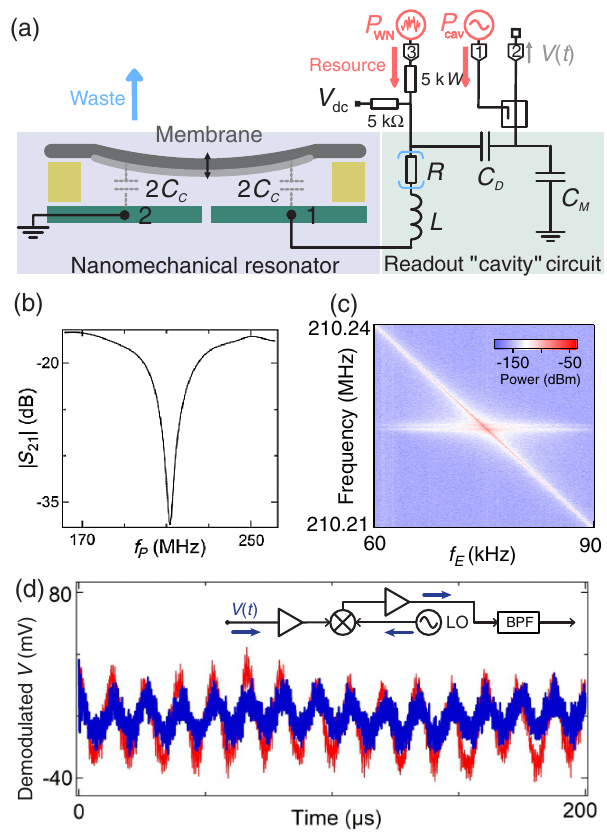
FIG. 2. (a) Experimental setup. A metalized silicon nitride membrane is suspended over two metal electrodes, forming a capacitor C . One of the electrodes is connected to a rf tank circuit C which acts as a readout cavity. Electrode 2 is grounded. The tank circuit is formed from a 223 nH inductor L , and two 10 pF capacitors C and C . Parasitic capacitances contribute to C and D M M parasitic losses in the circuit are parametrized by an effective resistance R . The cavity can be probed by injecting a rf signal at port 1 via a directional coupler. The output signal is measured at port 2 using a vector network analyzer or a spectrum analyzer. The membrane ’ s motion can be excited by injecting a signal at port 3. Bias resistors allow a dc voltage V to be applied to electrode 1. dc Red (blue) arrows indicate resources (waste) for our system. (b) j S 21 j as a function of probe frequency f . (c) One of the p mechanical sidebands observed in the spectrum of the cavity output signal when an excitation tone at frequency f is injected at E port 3 and swept in frequency while the cavity is driven at its resonant frequency via port 1. The sideband power grows when f E coincides with the resonance frequency of the membrane f 0 . (d) Demodulated readout signal V ð t Þ , as a function of time, for 14 dBm. P 0 . 25 W and P 0 . 063 W for the red P cav ¼ WN ¼ WN ¼ and blue traces, respectively. The inset shows the demodulation circuit. (LO, local oscillator; BPF, bandpass